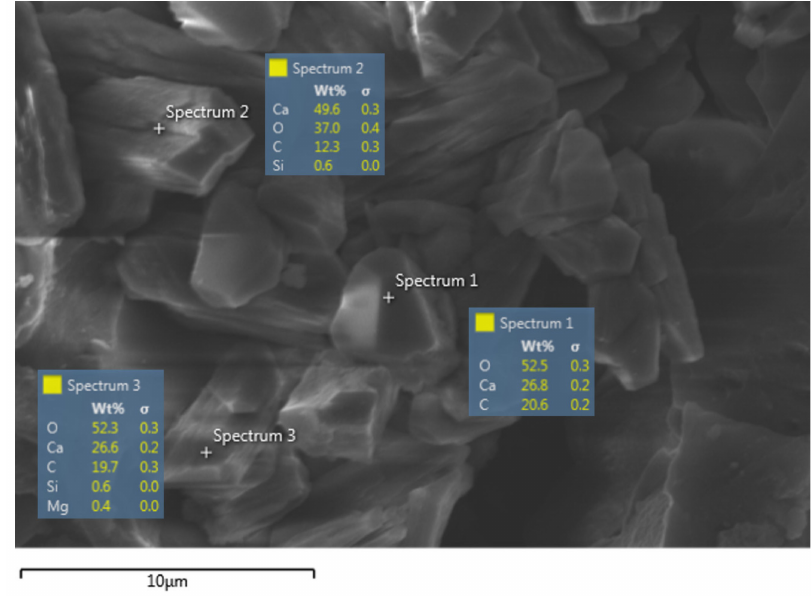
Figure 9. Elemental composition of the mineral precipitates via EDX